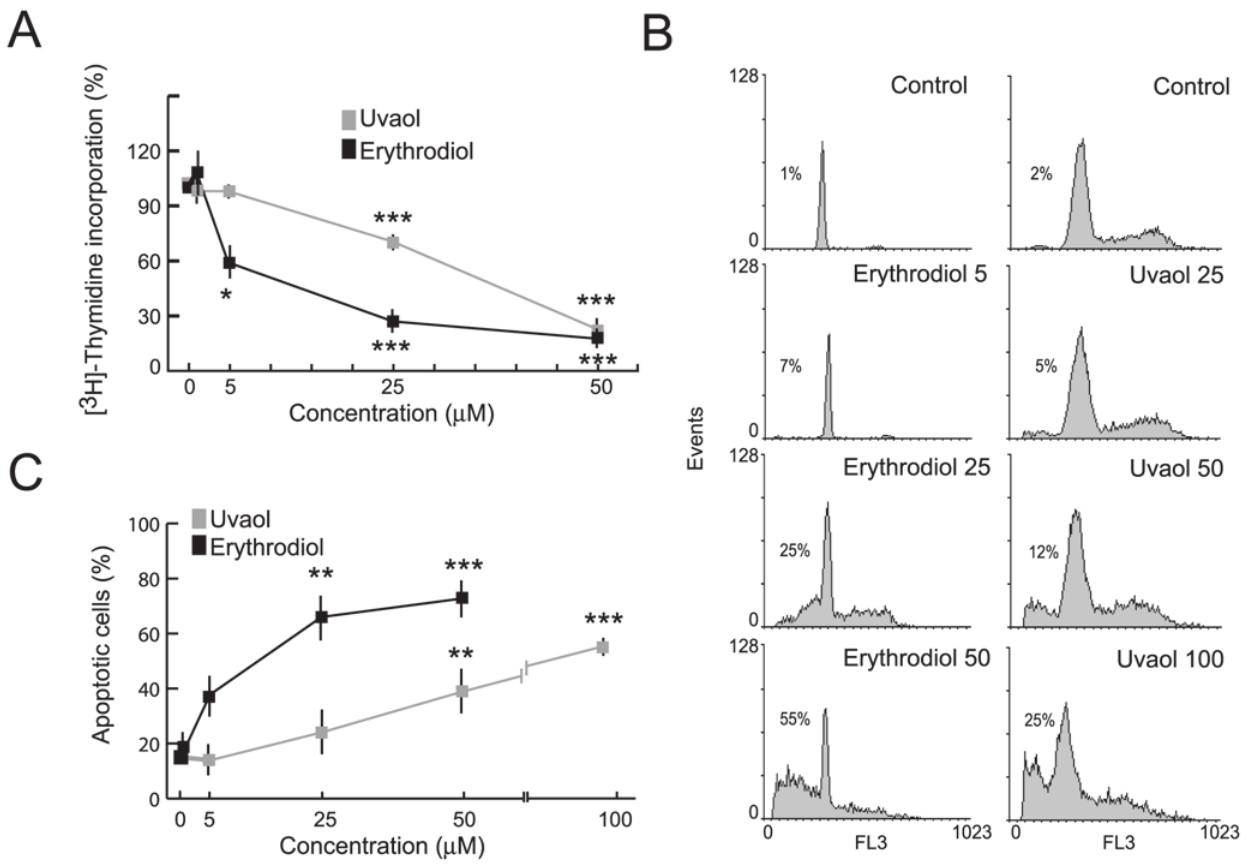
Figure 4. Effects of triterpenic diols on cell growth and apoptosis in 1321N1 cells. A, The cells were exposed to different doses of erythrodiol or uvaol for 18 h in the presence of FCS and proliferation was determined by a [ 3 H]-thymidine uptake assay. Data are expressed as the percentage of radioactivity incorporated in FCS-stimulated cells in the absence of triterpenes (327.510 6 3.889 dpm). B, C, Cells treated as above, but without FCS, were fixed in 70% ethanol and stained with PI (B) or stained with annexin-V-PE (C) and analyzed by flow cytometry. The numerical values are presented as the mean 6 S.D. of three independent experiments. Percentages in B indicate the number of cells in the sub–G0-G1 phase of the cell cycle. *p , 0.05, **p , 0.01, ***p , 0.001 vs control untreated cells.